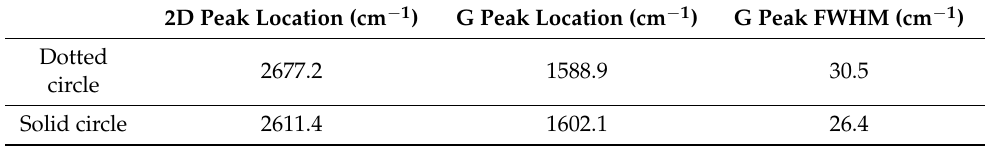
Table 1. Spectral information from Figure 1 (Table 1 was reprinted with permission from ref.